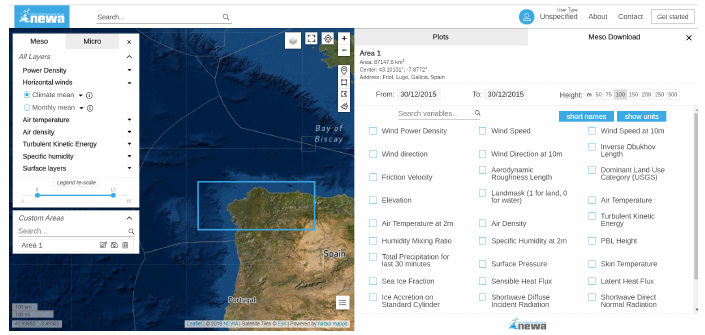
Figure 4. NEWA website. Data source: [115].